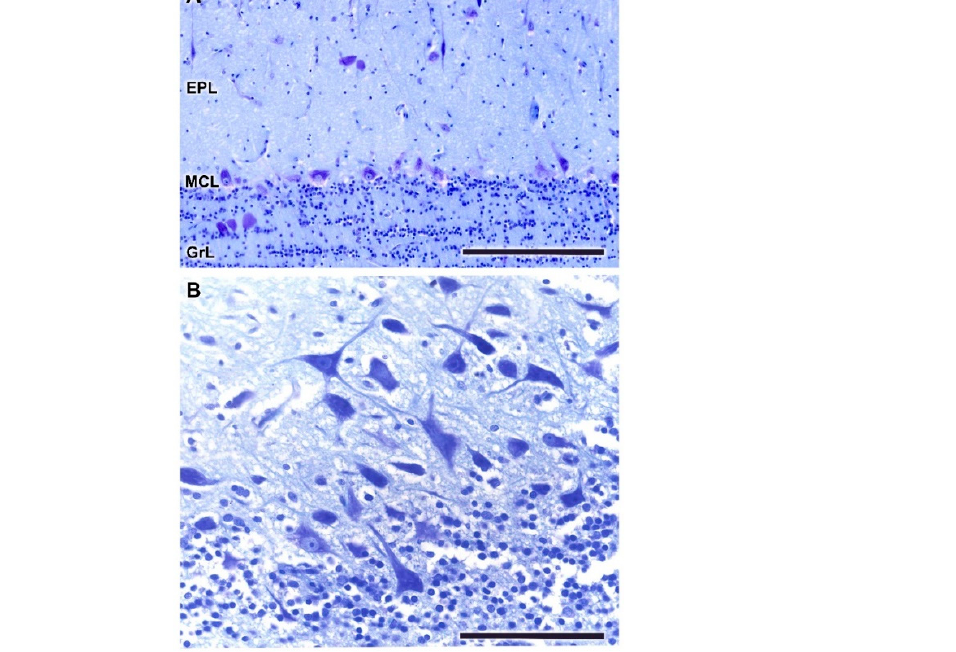
Figure 20. Histological study of the mitral cell layer of the olfactory bulb of the fox. ( A ) Nissl staining of a transverse section of the olfactory bulb showing mitral cell somas aligned along the MCL. ( B ) A sagittal section of the mitral cell layer (MCL) stained with Nissl staining shows the typical mitral cells characterized by their big soma and well-defined dendritic projections. Scale bars: ( A ): 250 µm. ( B ): 100 µm.